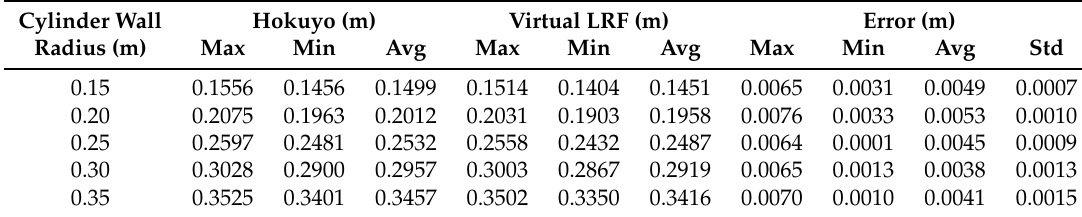
Table 2. Numerical comparison between Hokuyo LRF and proposed virtual